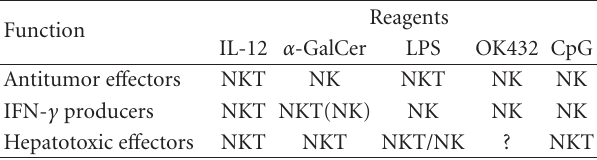
Table 2: Antitumor or hepatotoxic e ff ectors in the